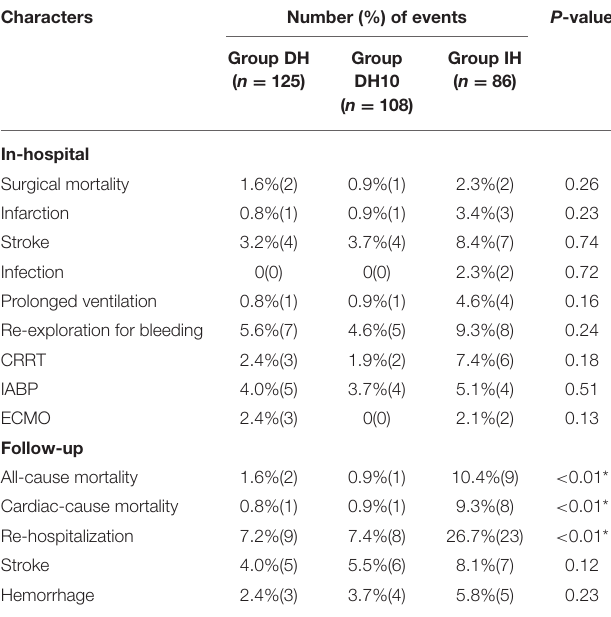
( Table 6 ). A downward trend in HbA1c during the